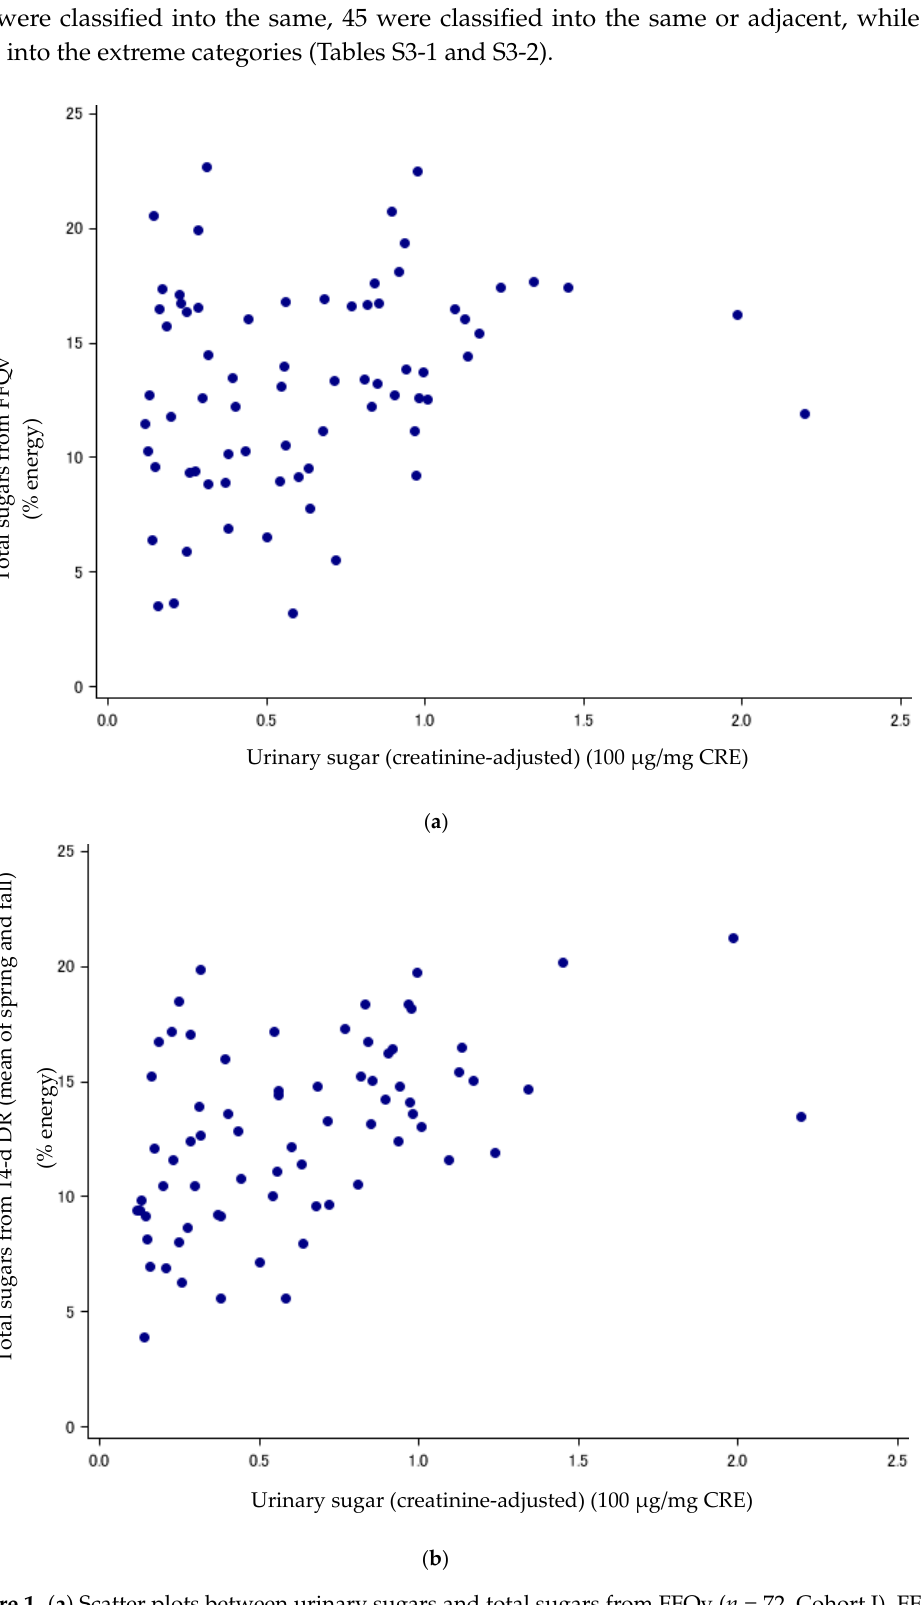
Figure 1. ( a ) Scatter plots between urinary sugars and total sugars from FFQv ( n = 72, Cohort I). FFQv, food frequency questionnaire for validity. ( b ) Scatter plots between urinary sugars and total sugars from DR ( n = 72, Cohort I). DR, dietary record.